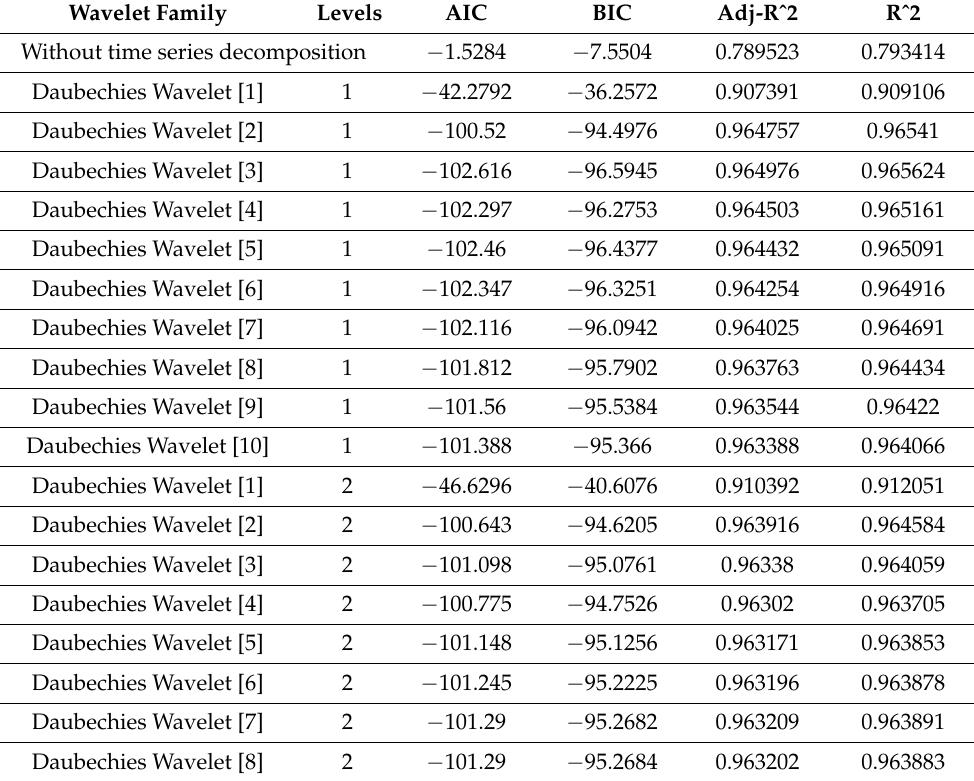
Figure 10. Cross-wavelet correlations of actual values of the original time series and predicted values were obtained through DW [3.1] and DW [8.8] transformations at five scale levels. Source: authors’ calculations. Table 1. Criteria for the adequacy of forecasting models based on the Daubechies wavelet packet transform to the time series of the values of daily cash balances in the 2019 federal budget TSA. Wavelet Family Levels AIC BIC Adj-Rˆ2